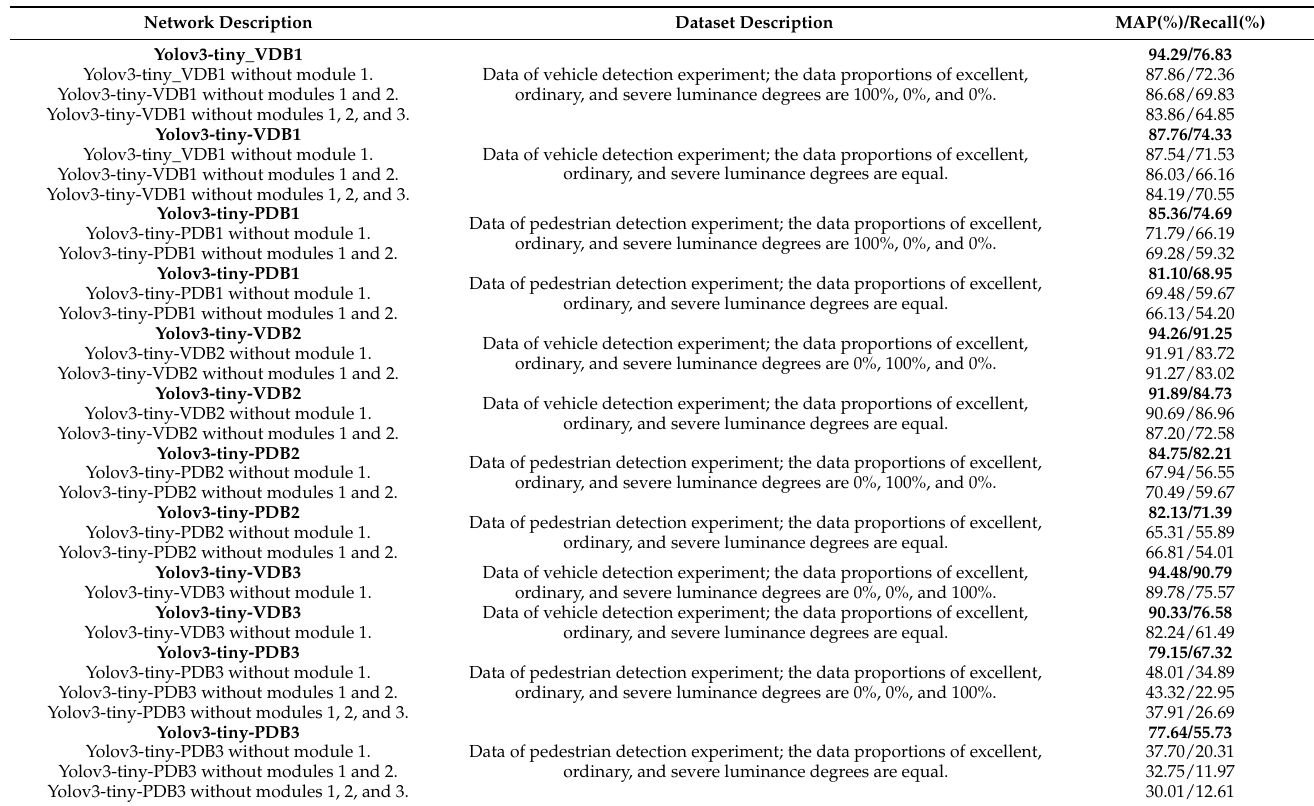
Table 7. Ablation analysis results using different networks and